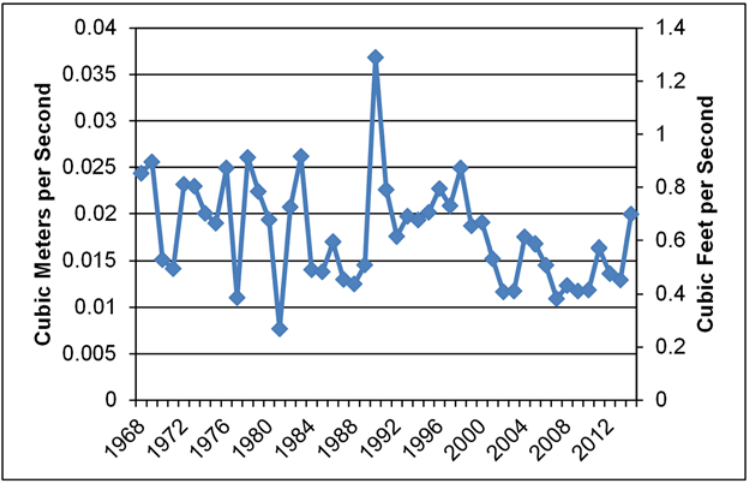
Fig 5. Elder Creek annual seven-day low flow. Values are shown for the period of record (water years 1968 – 2014).